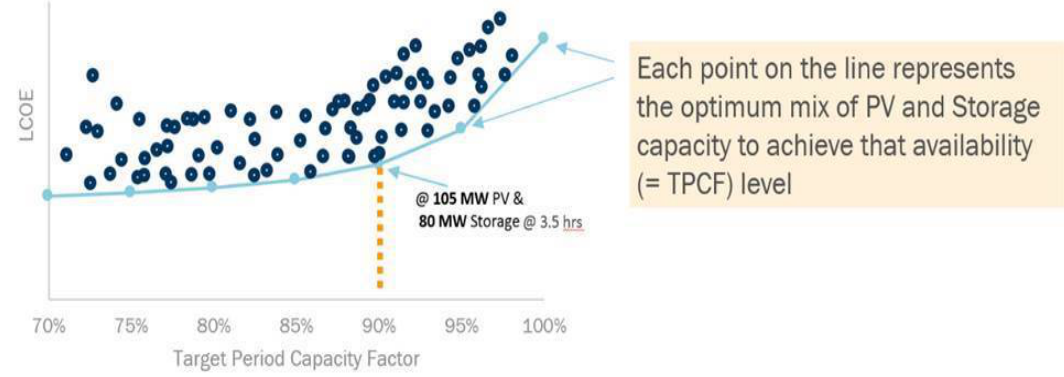
Figure 4. An illustration of Levelized Cost of Electricity (LCOE) vs. target period capacity factor (TPCF) showing the different system sizes (represented by dots) which can meet the TPCF requirement. Source: First Solar PVS Analytics.